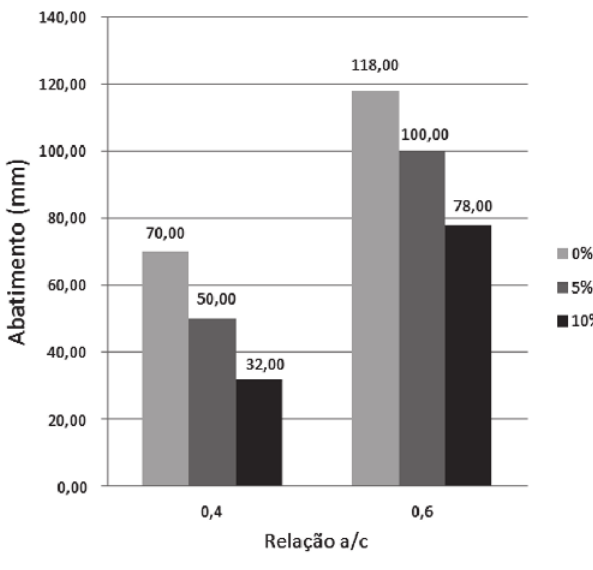
Resultados dos ensaios de